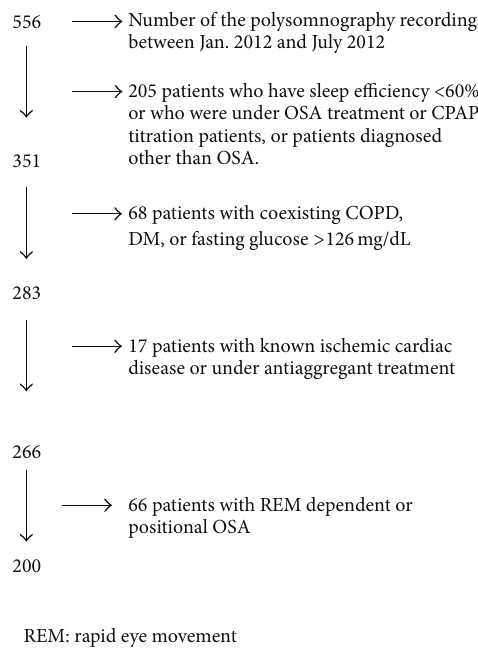
Figure 1: Exclusion chart of